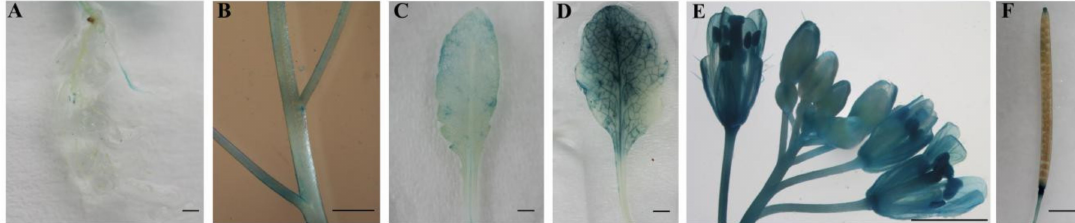
Figure 5. Tissue-specific GUS activity under the control of the CpWRKY71 promoter. T3 homozygous lines were used for GUS staining analysis. ( A ) Roots, ( B ) stems, ( C ) young leaves, ( D ) senescing leaves, ( E ) the whole inflorescence, ( F ) siliques. Bars denote 2